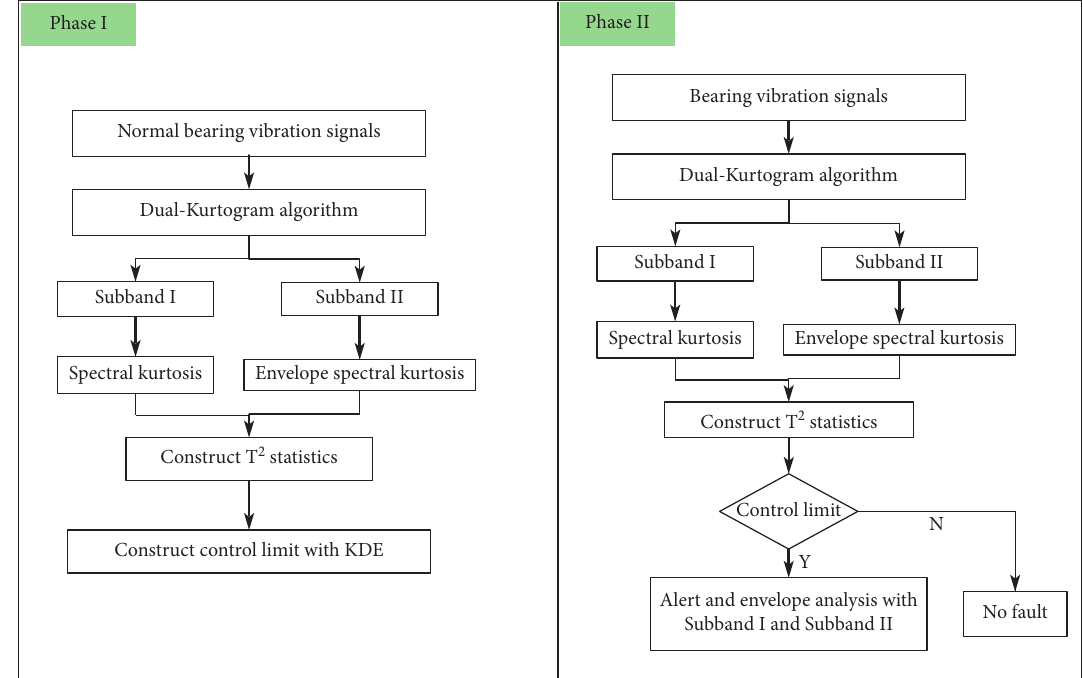
Figure 4: Flowchart of the Table 1: The simulation parameters.